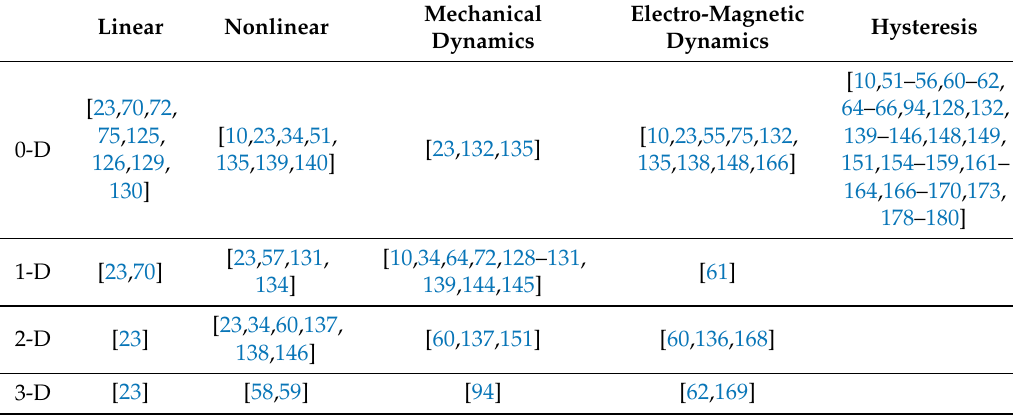
Table 3. Main papers, found in the literature, identified according to the geometry (rows) and type of modeling (columns). 0-D is equivalent to a lumped